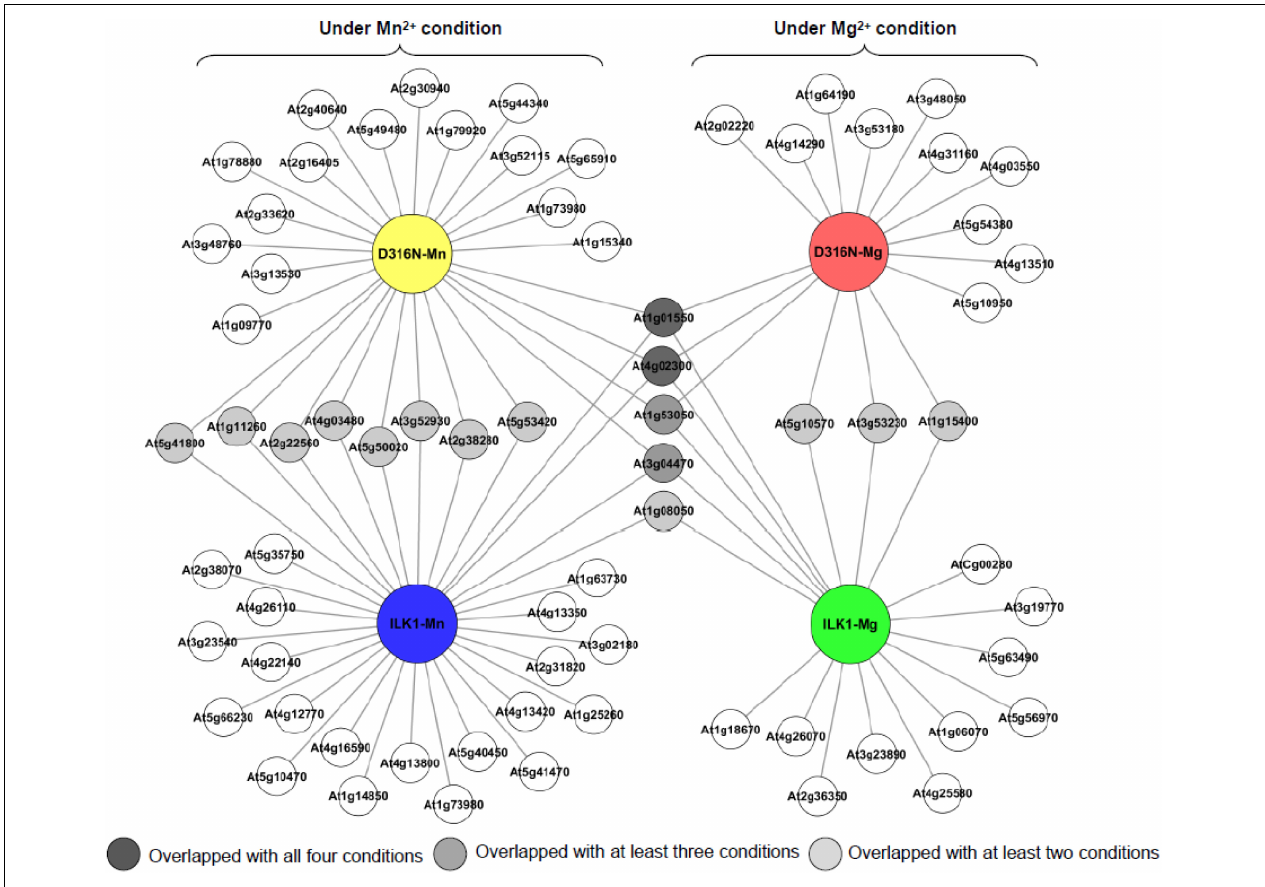
FIGURE 1 | Topological relationship of the potential phosphorylation targets for ILK1 and the ILK D316 N hyperactive mutant identified by screening the phosphorylation status of a synthetic peptide library after incubation with purified ILK1 protein. Cofactor conditions included the use of either 5 mM MgCl 2 or MnCl 2 . The cartograph was assembled by Cytoscape 2.8.3